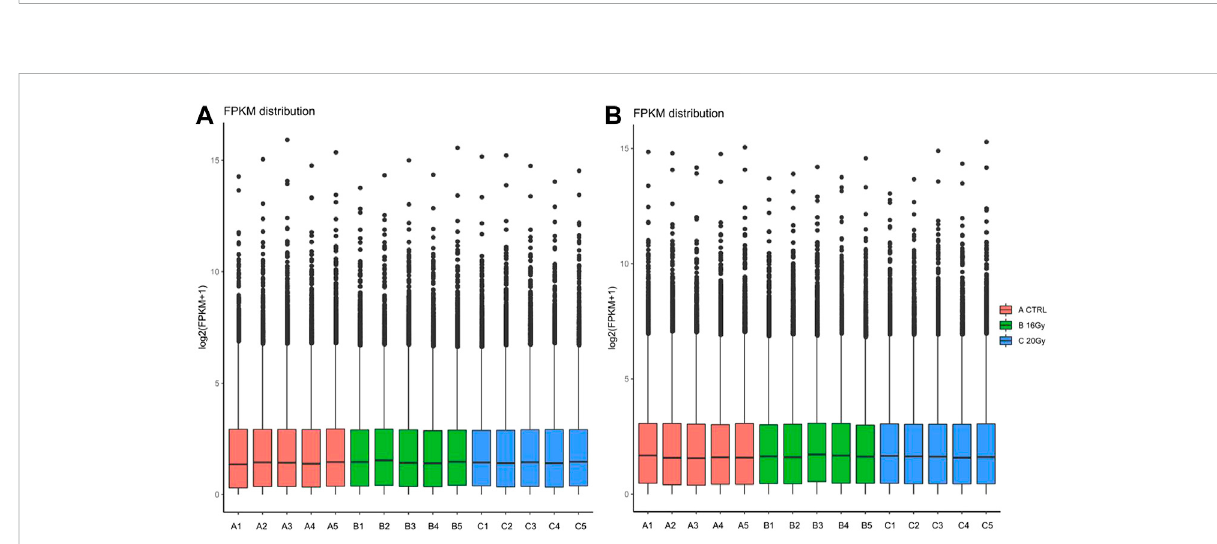
FIGURE 2 Distribution of gene expression values of mice quanti fi ed by FPKM algorithm at (A) 3 months after radiation therapy and (B) 6 months after radiation therapy. Thirty mice were randomized into 3 groups: control group, low-dose irradiation (16 Gy) group and high-dose irradiation (20 Gy) group. Lung tissues were harvested at 3 and 6 months after radiation to perform RNA sequencing. FPKM, fragments per kilobase of transcript sequence per million base pairs